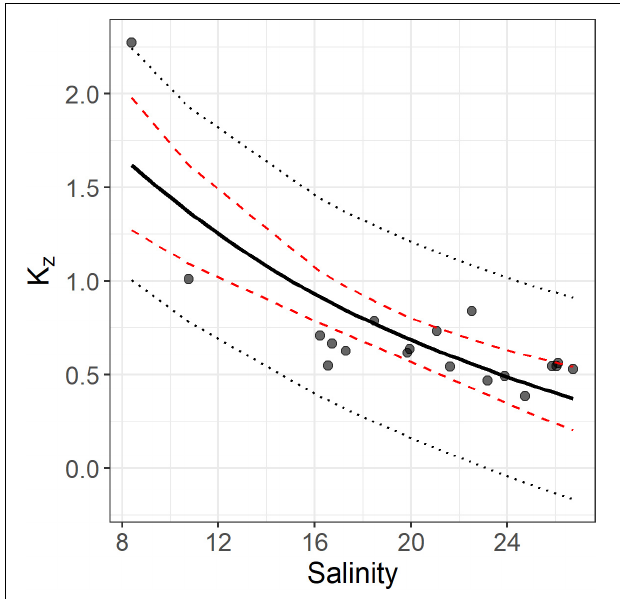
FIGURE 3 | Salinity and modeled kz values based on 19 CTD profiles acquired by Loos et al. (2017). The solid line shows the regression fit, dashed red lines show the 95% confidence interval for the regression, and the dotted black lines show the 95% prediction interval for the